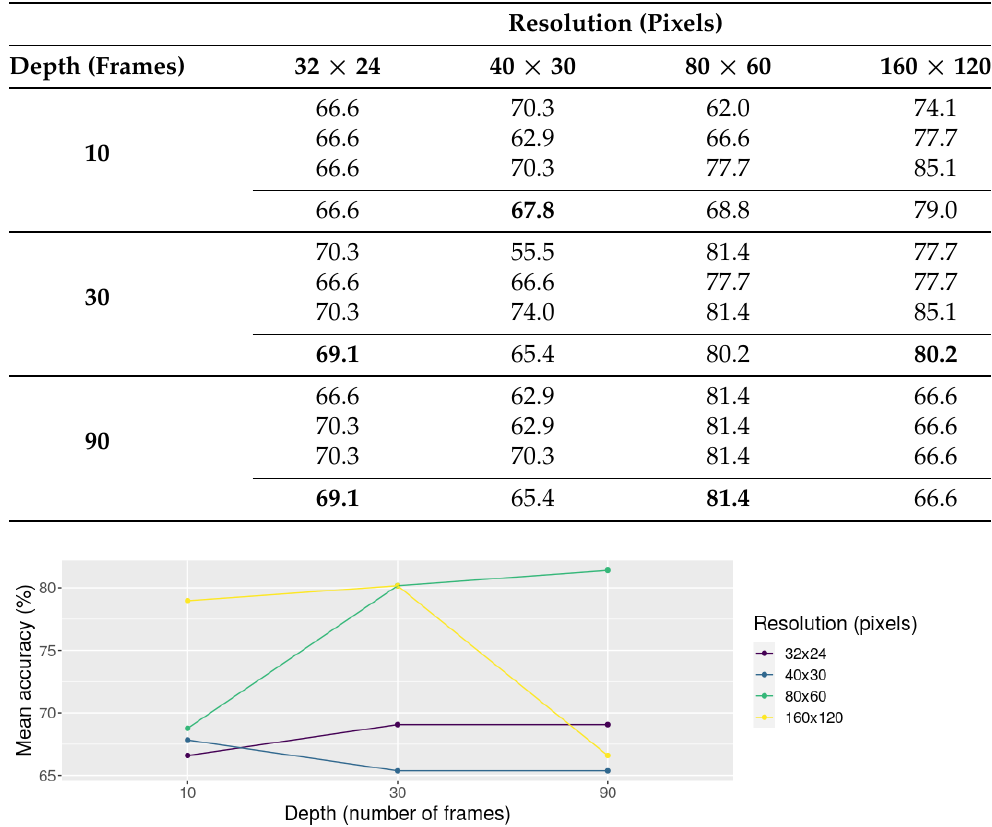
Figure 8. Interaction plot of depth (10, 30, and 90 frames) and resolution (32 × 24, 40 × 30, 80 × 60, and 160 × 120 pixels) using the accuracy values obtained from experiment